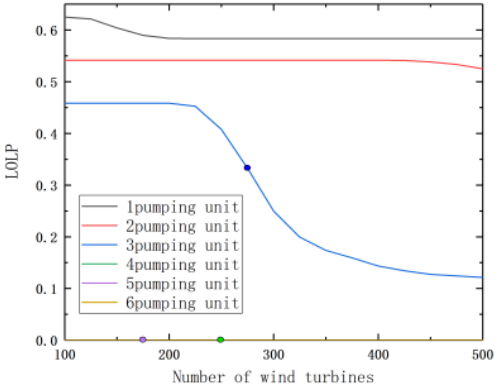
Figure 10. Probability of load loss (LOLP) for di ff erent capacity configuration